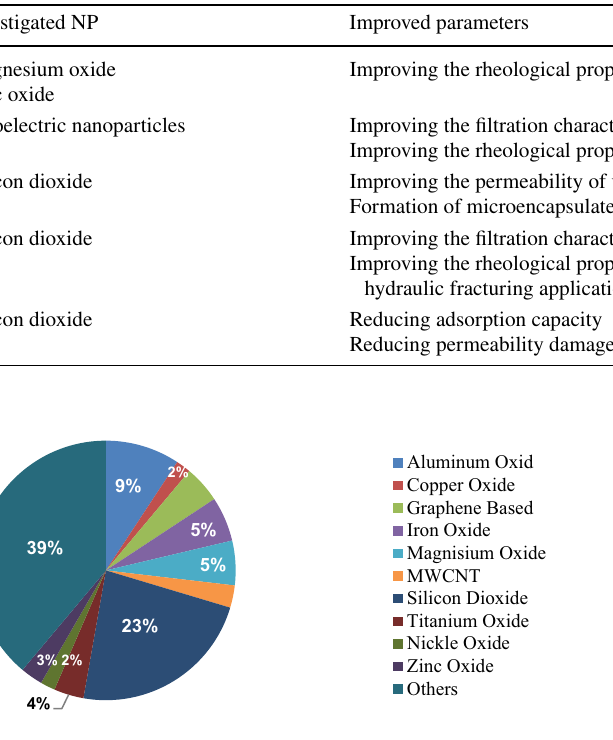
Fig. 2 Distribution of investigation for the different NP in the oil and